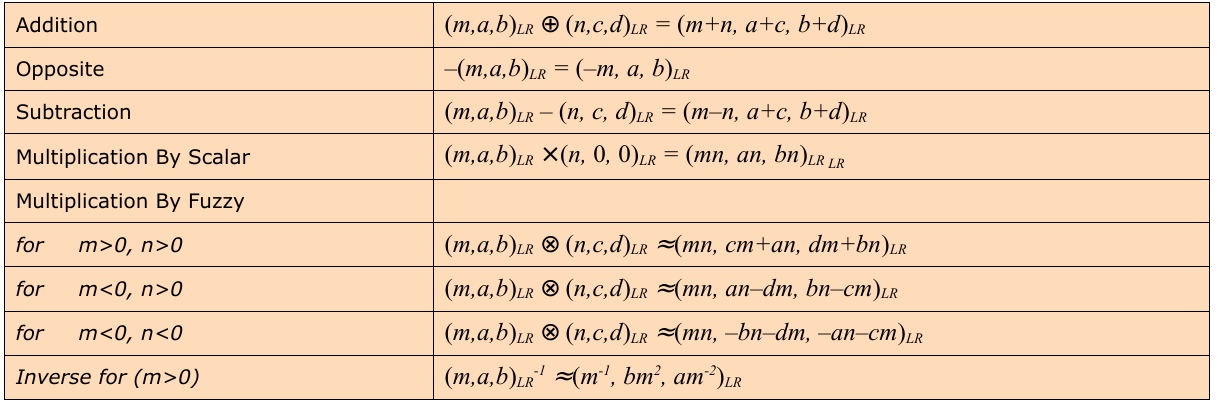
Table 1. Basic fuzzy